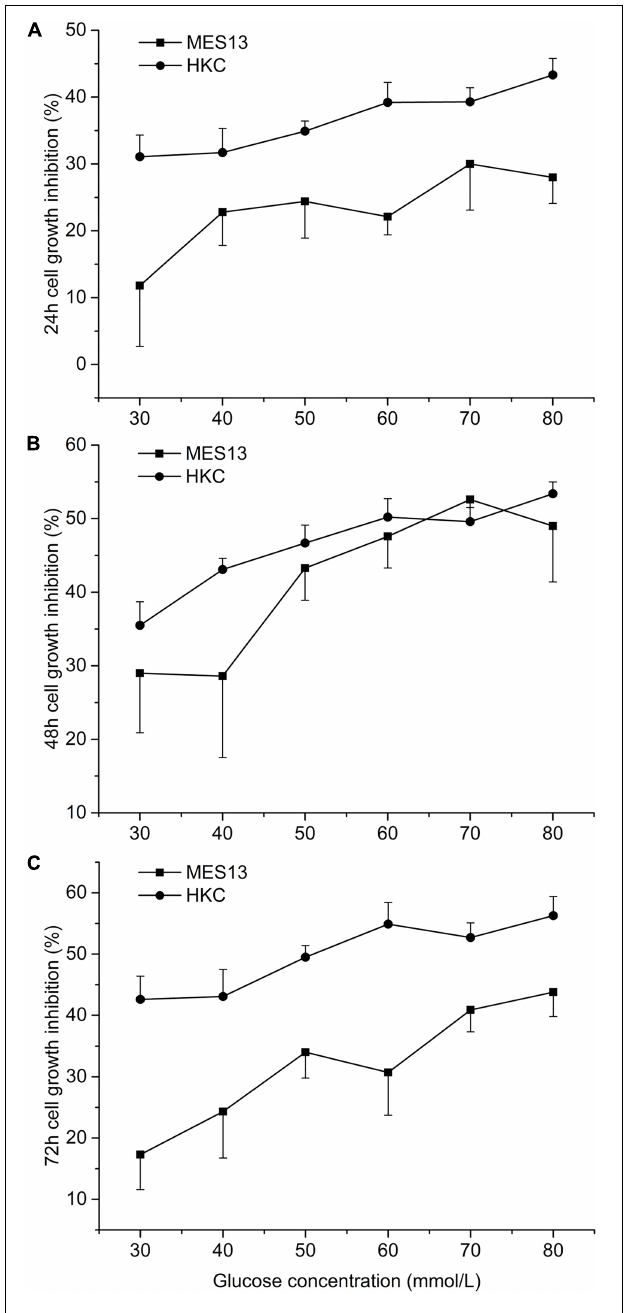
FIGURE 2 | Effects of different concentration of glucose on cell growth. After cell inoculation, cells were cultured for 24 h at incubator. Then each hole was added different concentration of glucose into the cell supernatant for 24 h (A) , 48 h (B) , or 72 h (C) . At the selected time point, the 96-well plate was taken out form the incubator for measuring the inhibition rate.